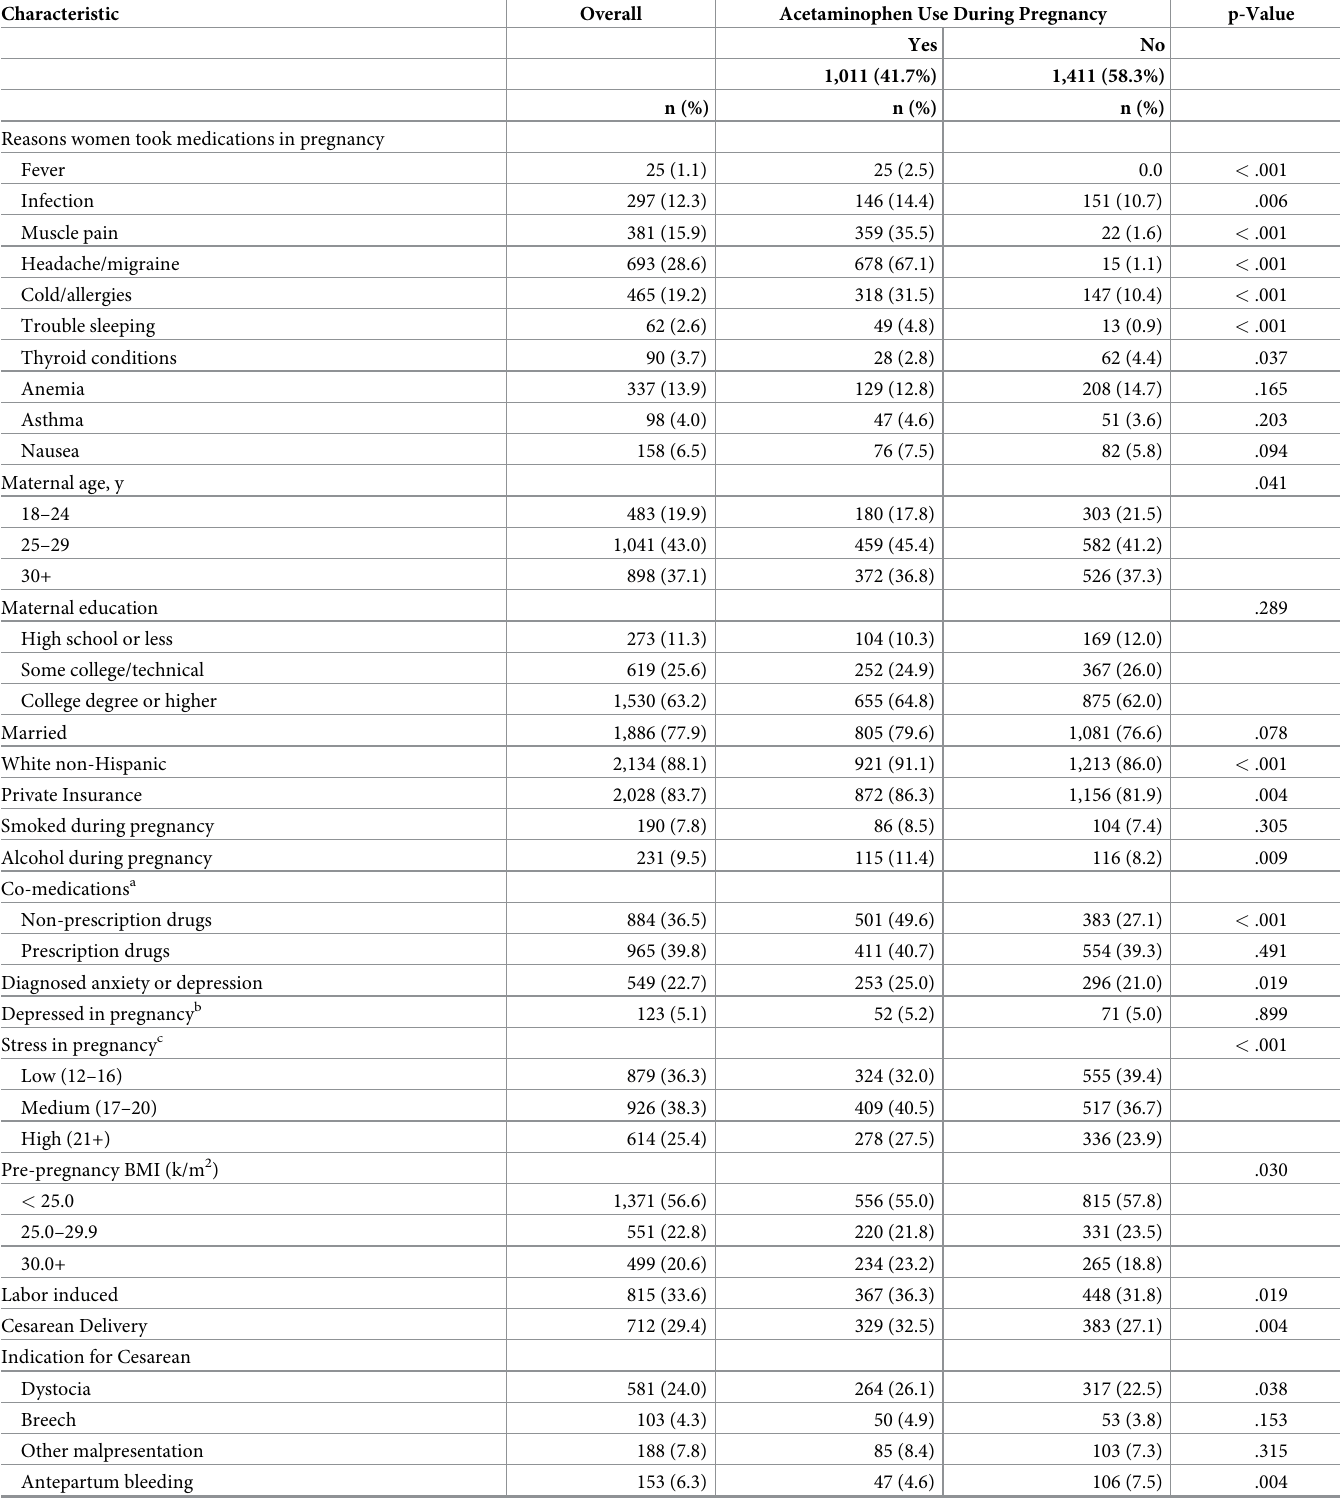
Table 1. Maternal and neonatal characteristics overall and by acetaminophen use during pregnancy (N = 2,422).